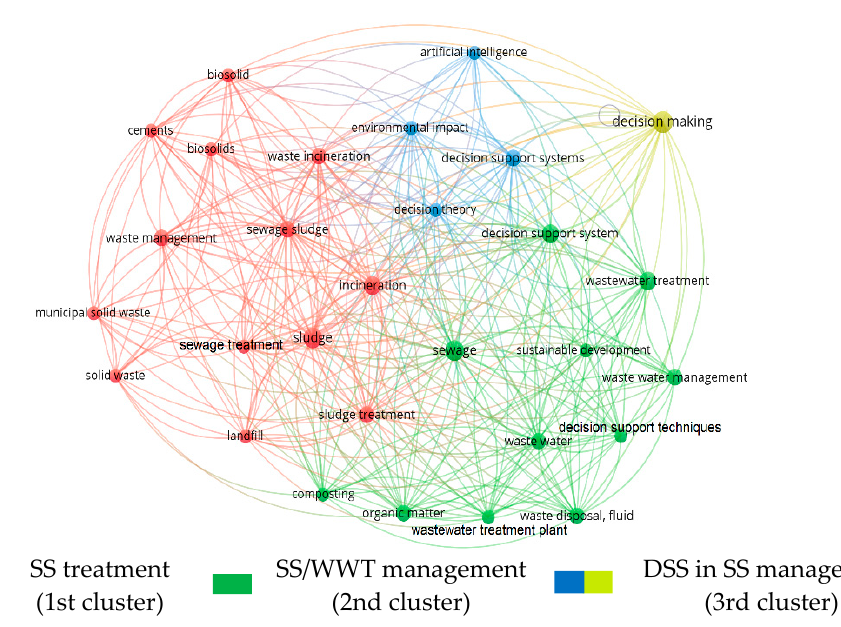
Figure 2. Authors’ keywords co-occurrence network map.